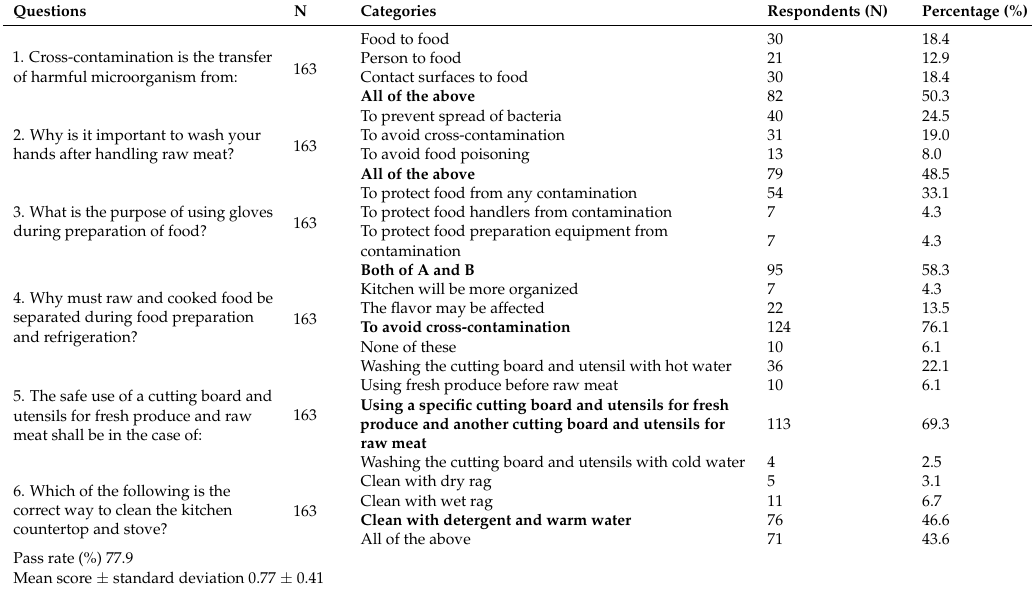
Table 4. Knowledge of foodservices staff on